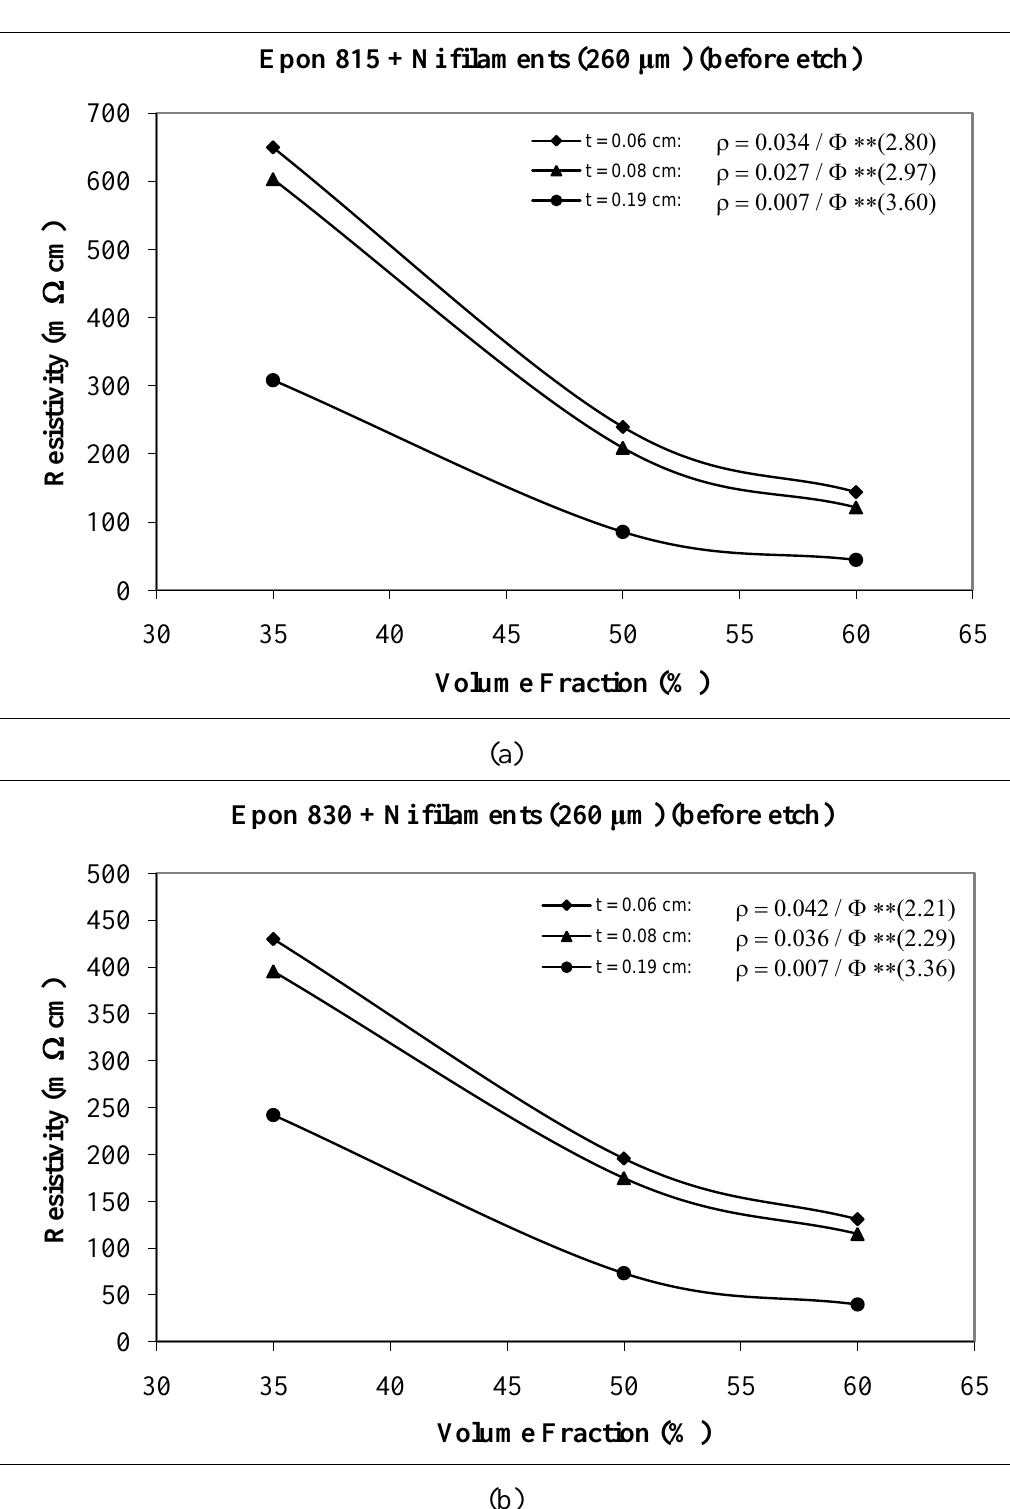
Figure 20. Volume fraction-thickness dependent resistivity of Epon 815C ( a ), and 830 ( b ) films filled with unetched nickel filaments (260 